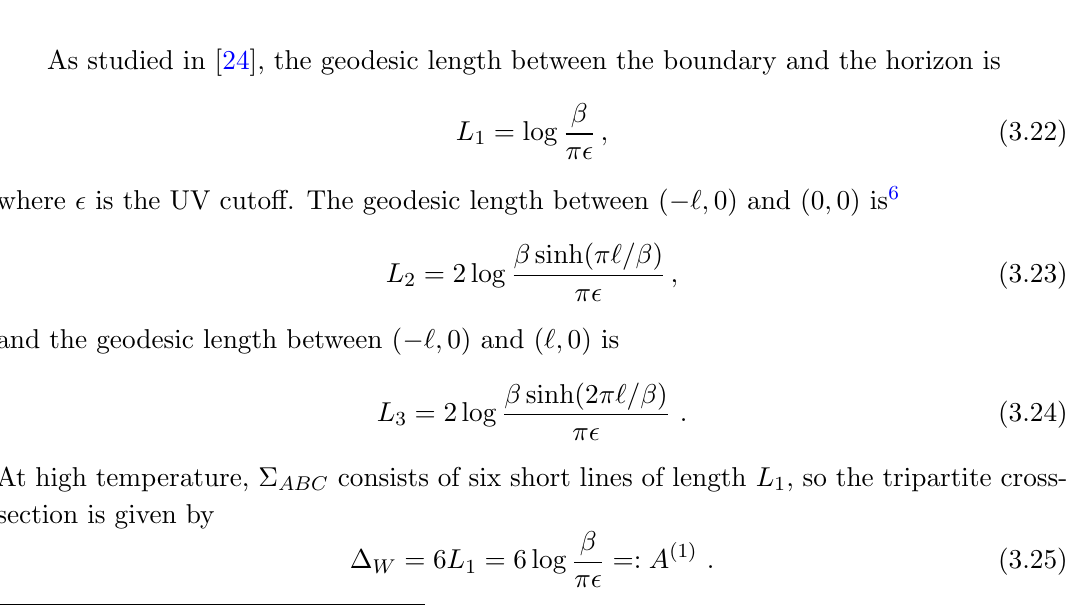
Figure 9 . The computation of (cid:1) W in